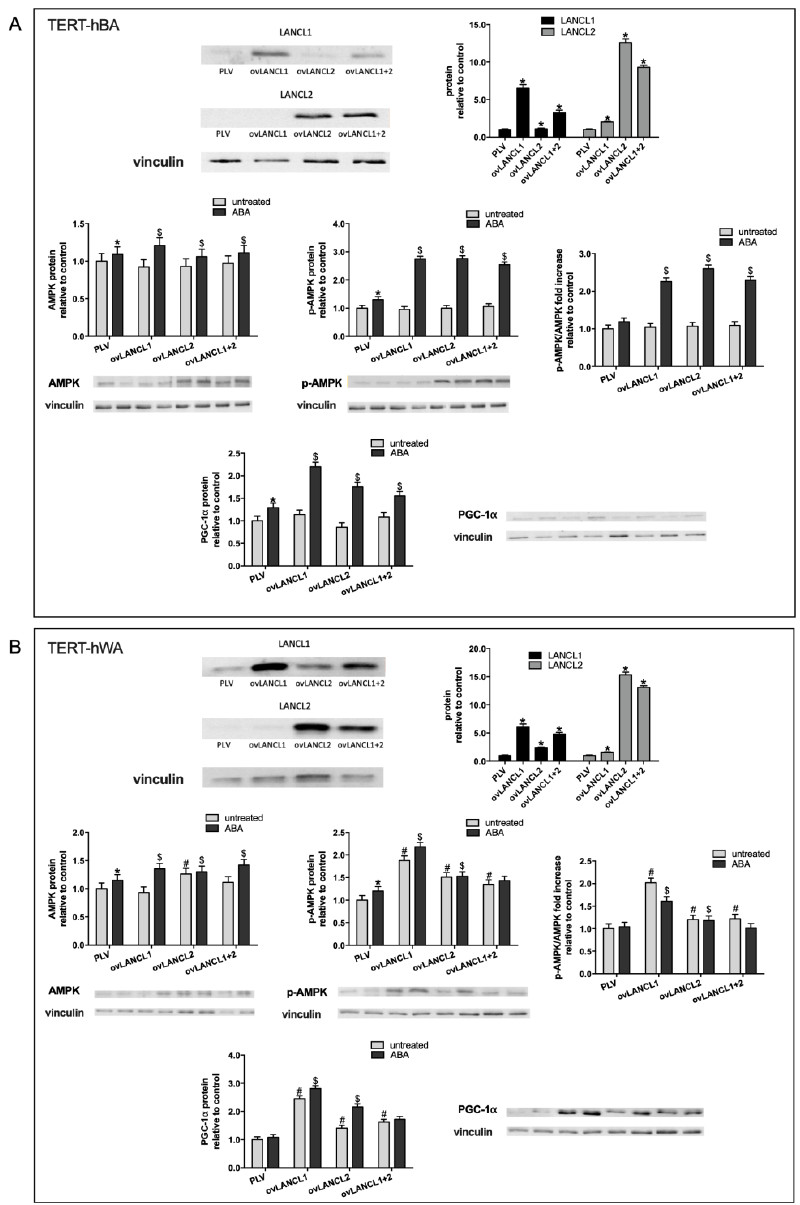
Figure 2. Overexpression of LANCL1/2 proteins increases total and phosphorylated AMPK and PGC-1 α protein levels in brown (TERT-hBA) and white (TERT-hWA) human preadipocytes. LANCL1 and/or LANCL2 were stably overexpressed in human TERT-hBA ( A ) or TERT-hWA ( B ) pre-adipocytes by viral infection. Upper left panels, representative Western blots of LANCL1/2 pro- teins in cells overexpressing LANCL1 (ovLANCL1), LANCL2 (ovLANCL2) or both LANCL1 and LANCL2 (ovLANCL1+2); upper right panels, densitometric quantitation of the LANCL proteins relative to control cells, transfected with the empty vector (PLV); total AMPK, phosphorylated (Ser473) AMPK (pAMPK), p-AMPK/AMPK ratio and PGC-1 α in cells overexpressing LANCL1 (ovLANCL1), LANCL2 (ovLANCL2) or both LANCL1 and LANCL2 (ovLANCL1+2), relative to PLV. The order of the samples is the same in the quantifications and in the representative blots except for the lower right and central panels of Figure 2A which show the first 4 bands for untreated samples and the last 4 bands for ABA-treated samples. Values are normalized against vinculin, as